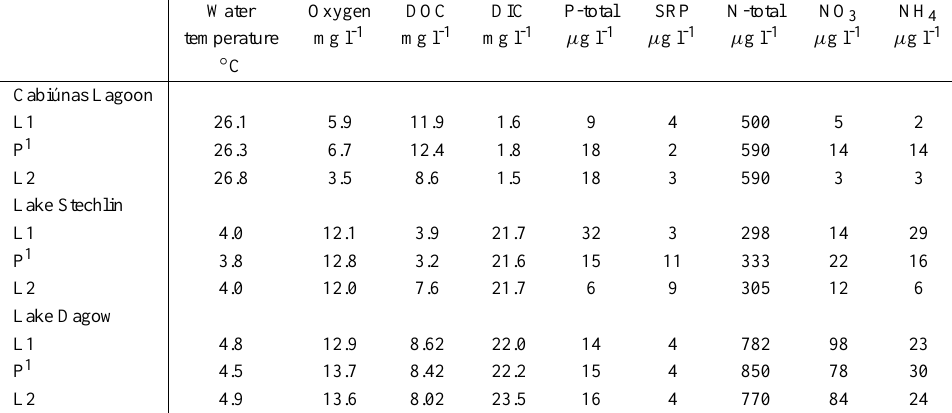
Measurements of water temperature, dissolved oxygen, dissolved organic carbon (DOC) and inorganic (DIC) and nutrients in Cabiúnas Lagoon on September 1998 and in Lake Stechlin and Lake Dagow on February 1997. The values were recorded on the day of